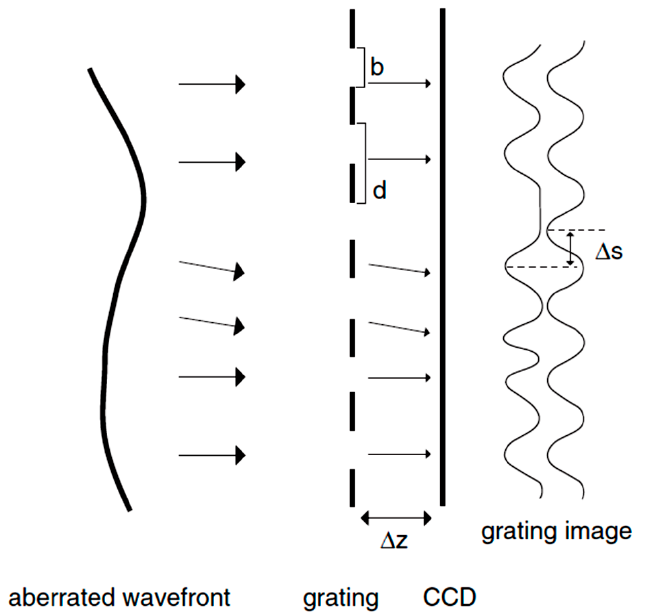
Figure 10. Talbot Moiré principle where d represents the spacing of the grating, b the width of the slit, Δ z the Talbot distance and Δ s the local phase shift of the fundamental frequency component of the grating image. Figure reprinted from Ref. [15] New methods and techniques for sensing the wave aberrations of human eyes, M. Lombardo and G. Lombardo , Clinical and Experimental Optometry , 2009 Taylor & Francis Ltd., with permission of the publisher (Taylor & Francis Ltd., Abingdon-on-Thames, UK, http://www.tandfonline.com).